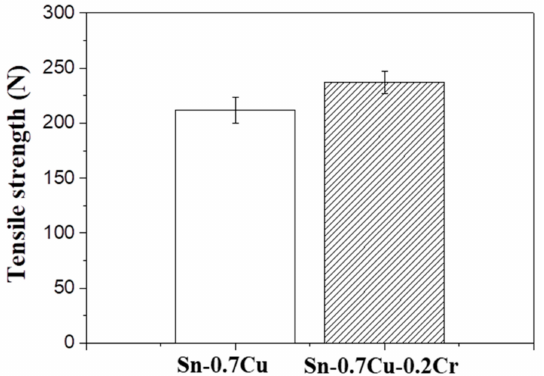
Figure 13. Tensile strength of Sn-0.7Cu and Sn-0.7Cu-0.2Cr solders.